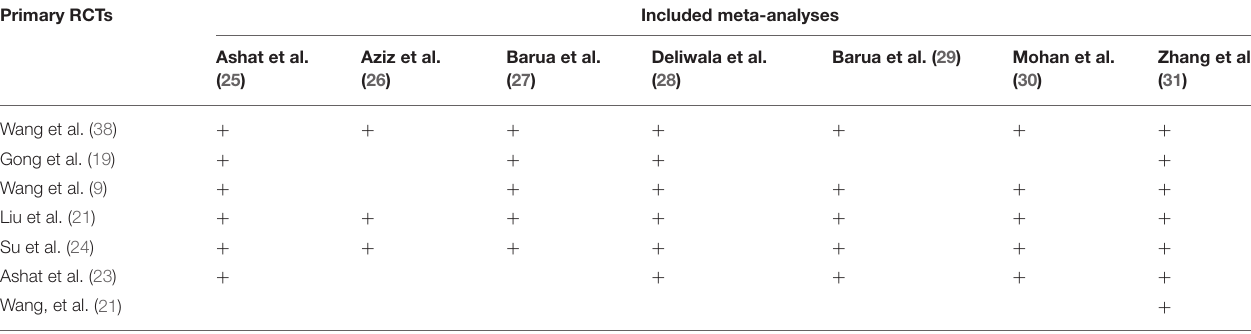
TABLE 2 | Primary RCTs incorporated into each eligible meta-analysis. Primary RCTs